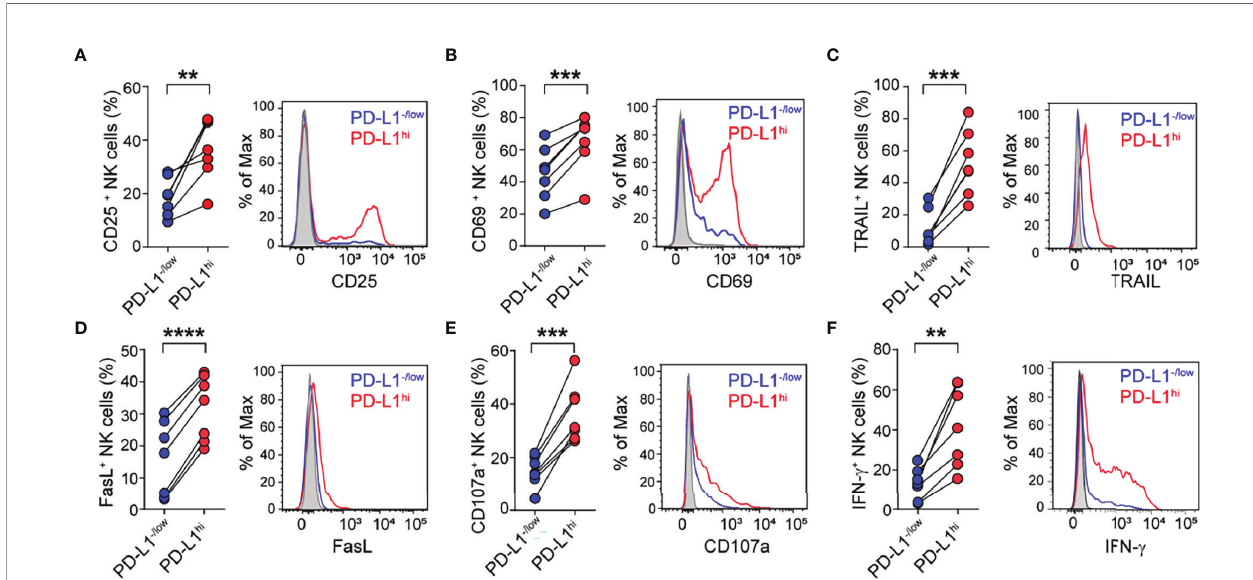
FIGURE 6 | PD-L1 hi NK cells exhibit an activated phenotype and express higher cytotoxic mediators. Frequency of CD25 + cells (A) , CD69 + cells (B) TRAIL + cells (C) , FasL + cells (D) , CD107a + cells (E) and IFN- g + cells (F) detected in PD-L1 hi (red) and PD-L1 -/low NK cells (blue) after stimulation of PBMC with K562 cells for 48 h, assessed by fl ow cytometry (n=7). A representative histogram for each marker is shown. Two-sided Student´s t test ** p <0.01, *** p <0.001, **** p <0.0001.